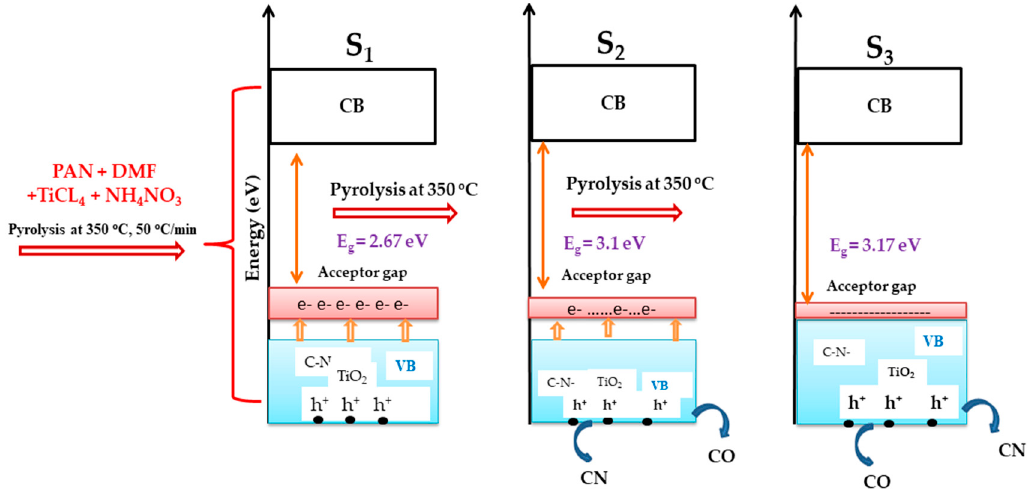
Figure 9. Schematic of changes occurring during pyrolysis of C–N–TiO 2 at 350 ◦ C for di ff erent holding times 105, 120 and 135 min (S 1 = C–N–TiO 2 105 min; S 2 = C–N–TiO 2 120 min and S 3 = C–N–TiO 2 135 min).